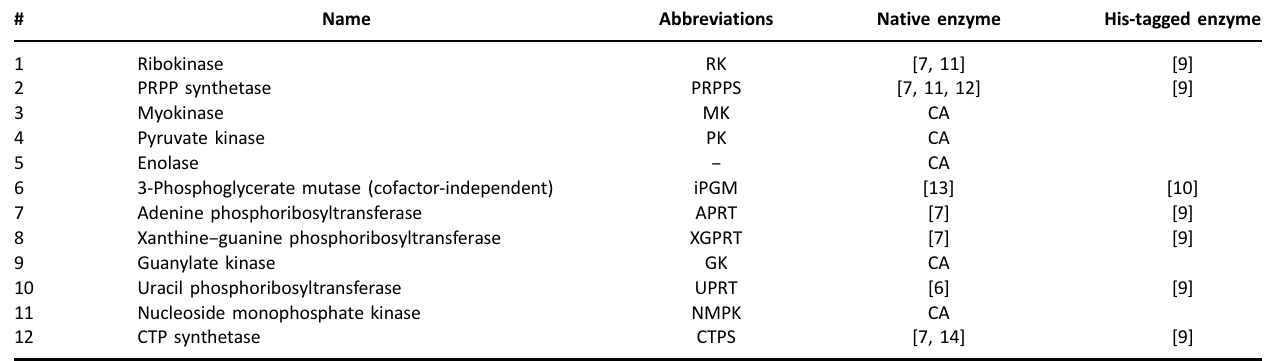
Table 1. Enzymes used for NTP